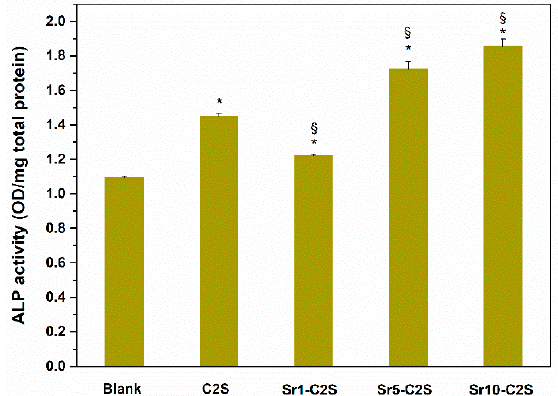
Figure 12. ALP activity of hBMSCs in the medium supplemented with C2S, Sr1-C2S, Sr5-C2S and Sr10-C2S after culturing for 10 days. The cells cultured in medium without C2S or Sr-C2S were treated as the control group. C2S and Sr-C2S groups demonstrate higher ALP activity of hBMSCs than blank group. Furthermore, Sr5-C2S and Sr10-C2S groups demonstrate higher ALP activity of hBMSCs than C2S group. * denotes significant difference exists between this group and the blank group. § denotes significant difference exists between this group and the C2S group.